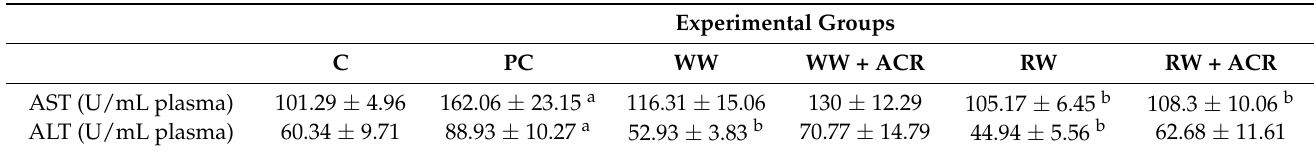
Table 4. Effects of white/red wine on aspartate aminotransferase and alanine aminotransferase levels in the plasma of rats from the 6 experimental